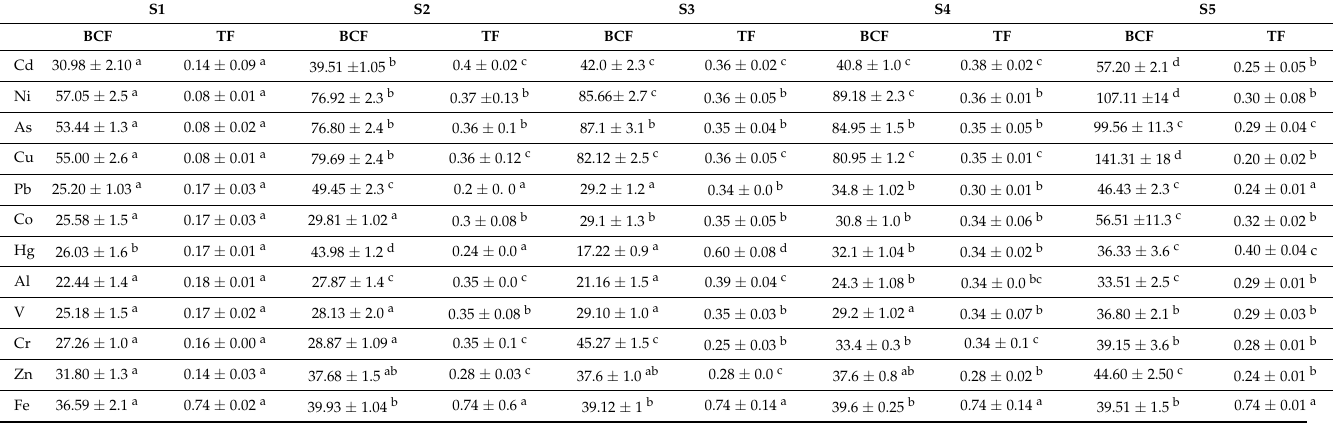
Table 4. Biological concentration factor (BCF) and translocation factor (TF) of S. portulacastrum grown in different control sites (Site 1) and contaminated sites (Sites 2–5). Data are mean values ± SE ( n = 4). Different letters (a–c) represent the significant differences between the effect of heavy metal stress in the different target sites (Tukey test ( p <